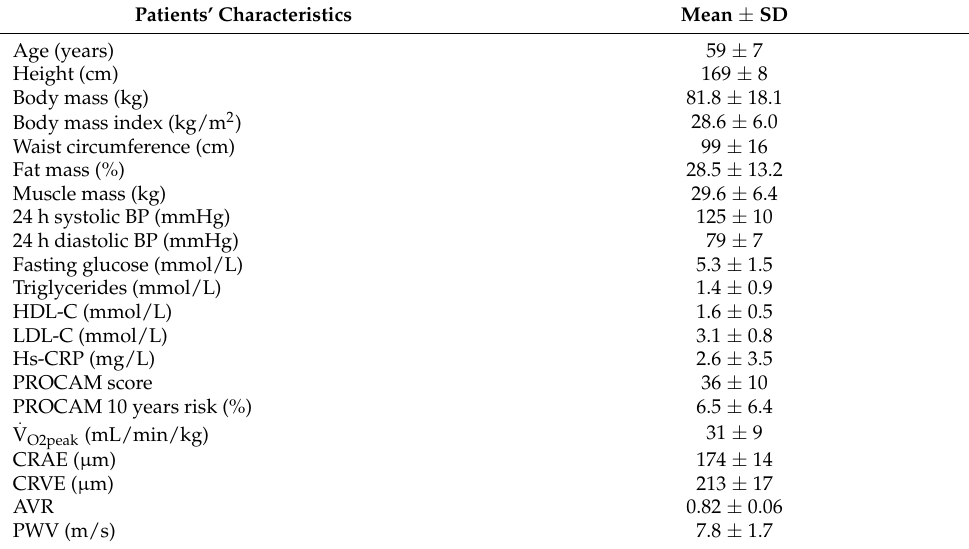
Table 1. Sample characteristics.